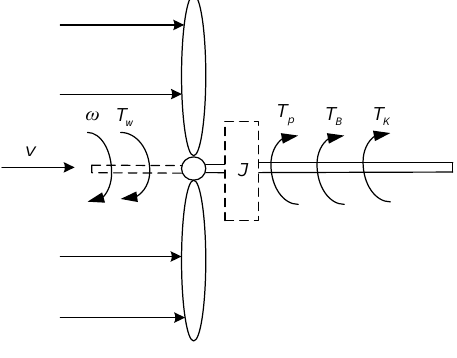
Figure 6. Wind turbine force analysis.